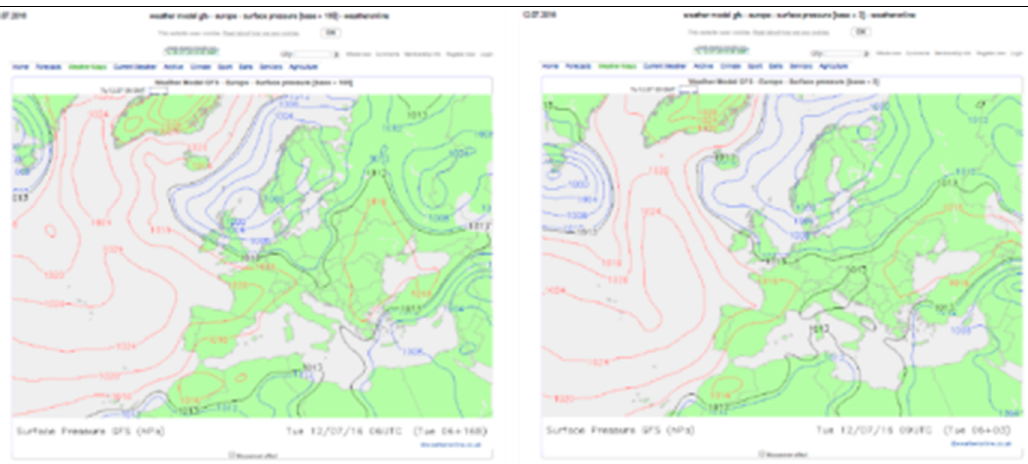
Figure 2. Precision of meteorological predictions. Source: Authors’ processing is based on data available on http://www.weatheronline.co.uk (accessed on :12.07.2016).